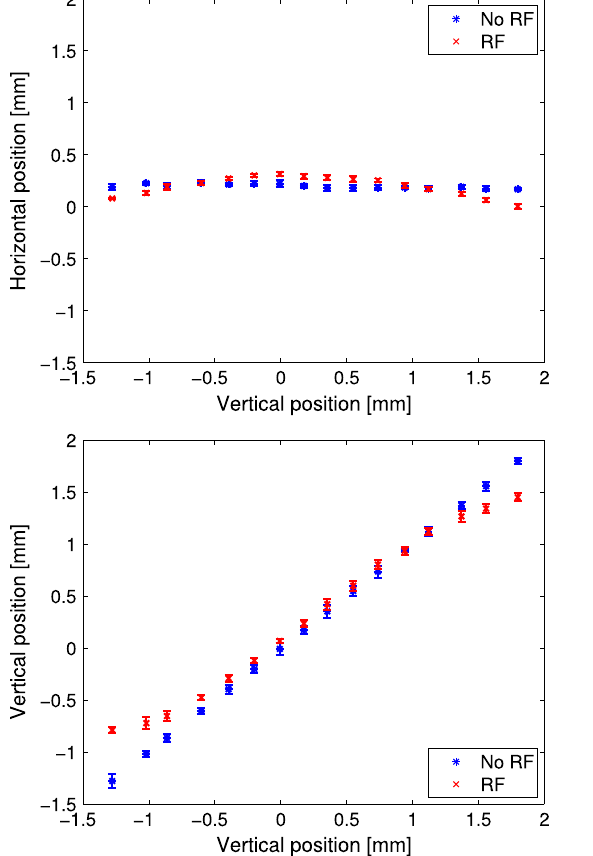
FIG. 5. Horizontal (top) and vertical (bottom) position of beam centroid on the screen for different vertical positions. Plots show both beam with and without rf inside the ACS. We can clearly see the position shifts due to the octupole field.